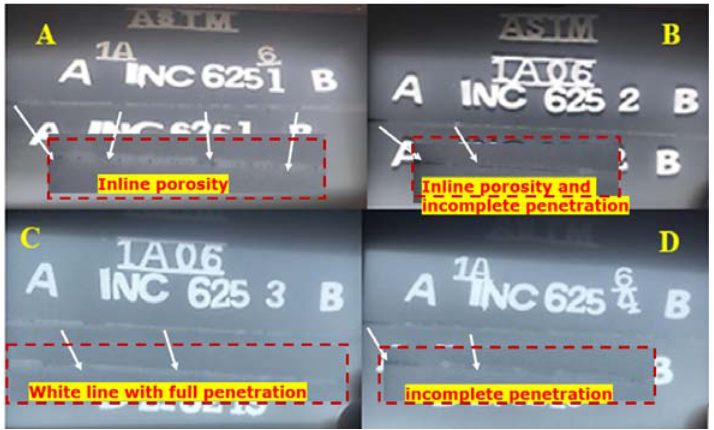
Figure 5. Weldments radiographic images ( A – D ).